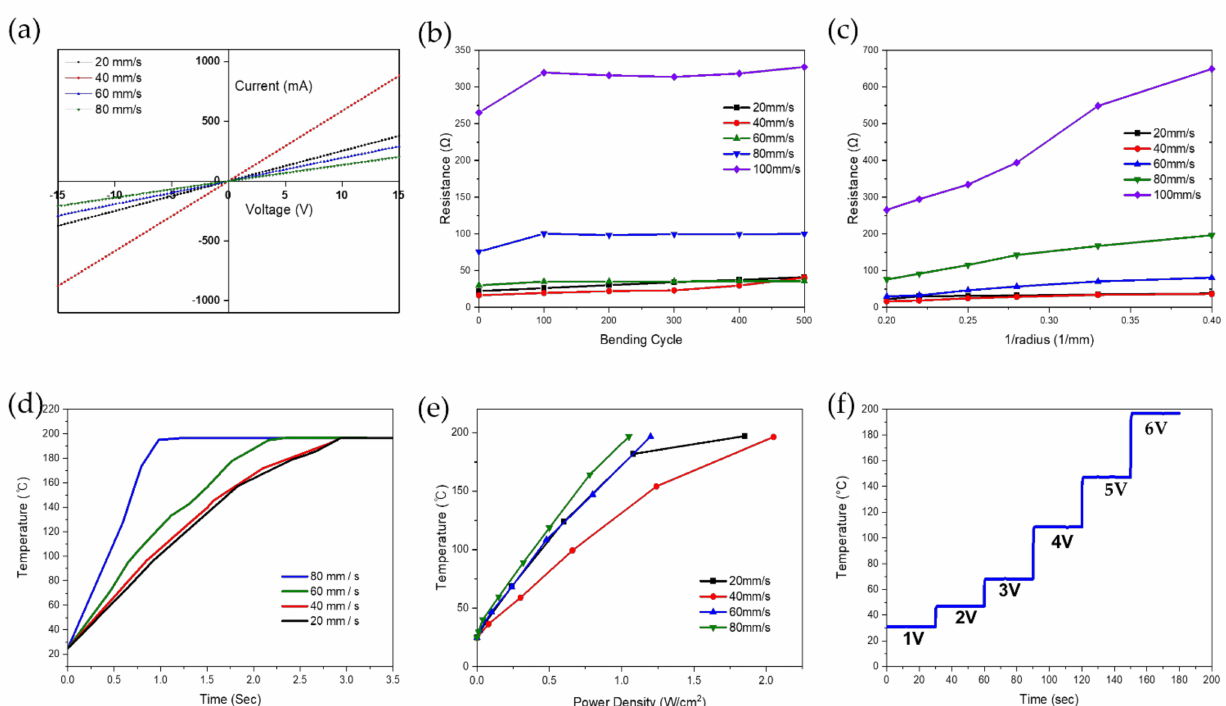
Figure 5. ( a ) I–V curve measurement of LIG patterns fabricated according to laser scanning speed. ( b ) Change in electrical resistance after cyclic bending. ( c ) Change in resistance as LIG patterns are bent by a cylinder of different radius. ( d ) Time- dependent characteristics of transient time to reach 200 ◦ C under 12 V. ( e ) Temperature as a function of the applied electrical power density for LIG heaters. ( f ) Temperature evolution of LIG heaters at stepwise voltage rise from 1 to 6